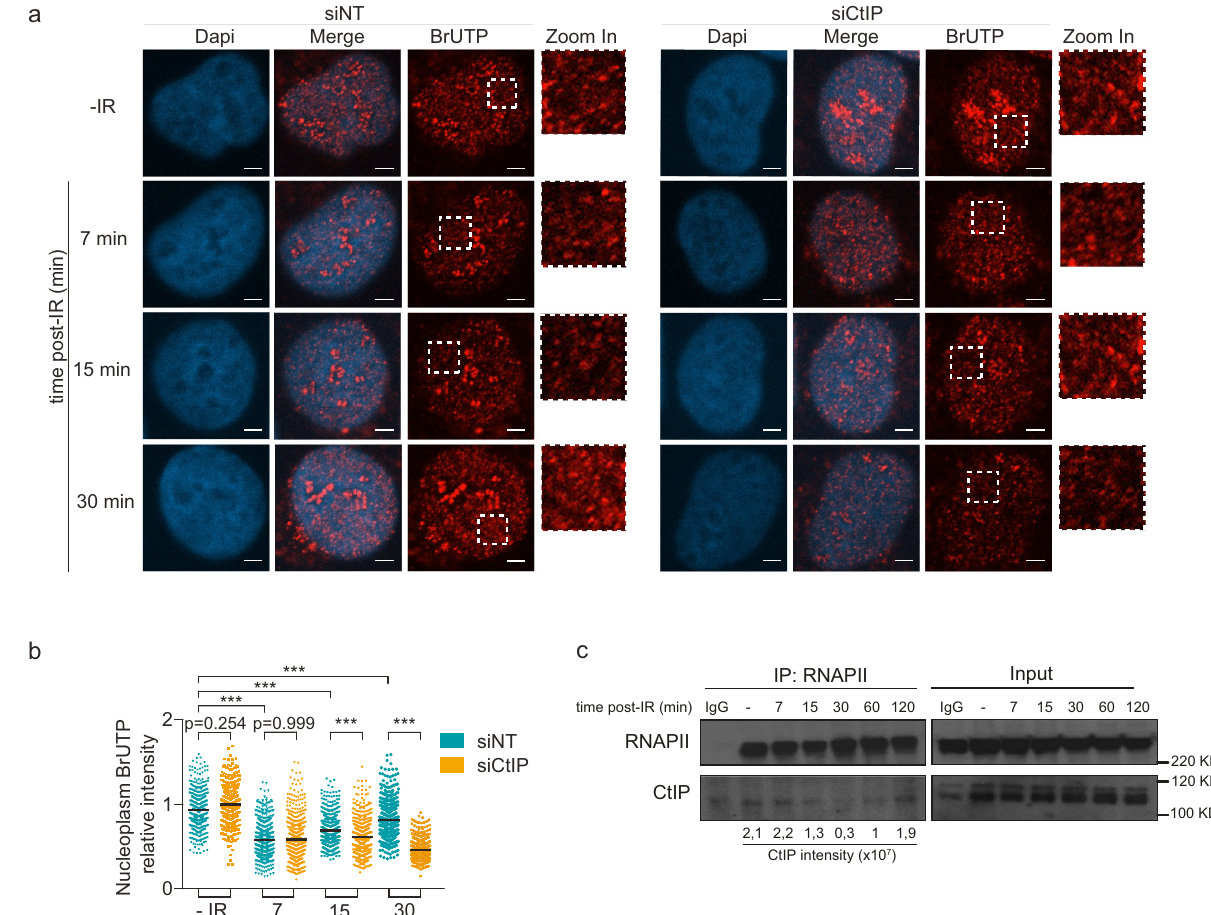
Fig. 6 | DNA resection de fi ciency prevents transcription re-start after DNA damage. a Representative images of de novo transcription based on BrUTP incorporation assay at 7, 15 and 30min post-IR (5Gy) in CtIP-depleted U2OS cells. Zoominpicturesareshown. n =3biologicallyindependentexperiments.Scalebar: 1 μ m. b Dot graph shows nucleoplasm (non-nucleolar) quanti fi cation of BrUTP incorporation under the experimental conditions cued in ( a ). At least n =200 cells examined over 3 independent experiments were quanti fi ed. Data are represented